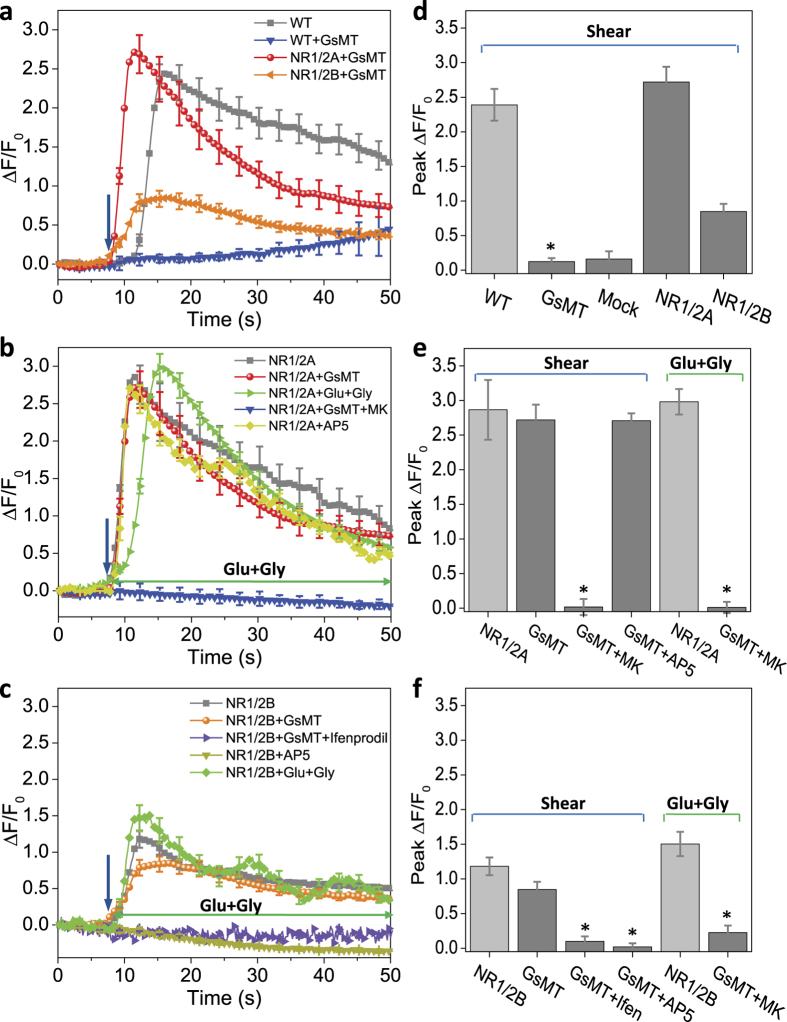
Ca2+ response to fluid shear stimuli in GluN1,2A and 2B expressing CHO cells.(a) The Ca2+ response to a shear pulse (23 dyn/cm2, 10 ms) in control cells (wild type, gray), with MSC inhibitor GsMTx4 (blue), and GluN1,2A (red) and GluN1,2B (orange) expressing cells in the present of GxMTx4, showing recombinant NMDA channels can be activated by shear stress without agonists. (b) Ca2+ response to shear pulse and glutamate-glycine (green) in GluN1,2A expressing cells, showing that glutamate antagonists do not inhibit shear responses. Results for the GluN1,2A expressing cells (red) are replotted for comparison. (c) Ca2+ response to shear pulse and glutamate-glycine (green) in GluN1,2B expressing cells, showing glutamate biding sites play a role on N2B subunit. Each curve is an average over 200 cells from >4 experiments under each condition. Error bars indicate s.e.m. (d–f) Peak Ca2+ response in each conditions corresponding to (a–c), respectively. Cells treated with various drugs were compared with control cells with corresponding stimuli (*p < 0.05). Error bars indicate s.e.m.